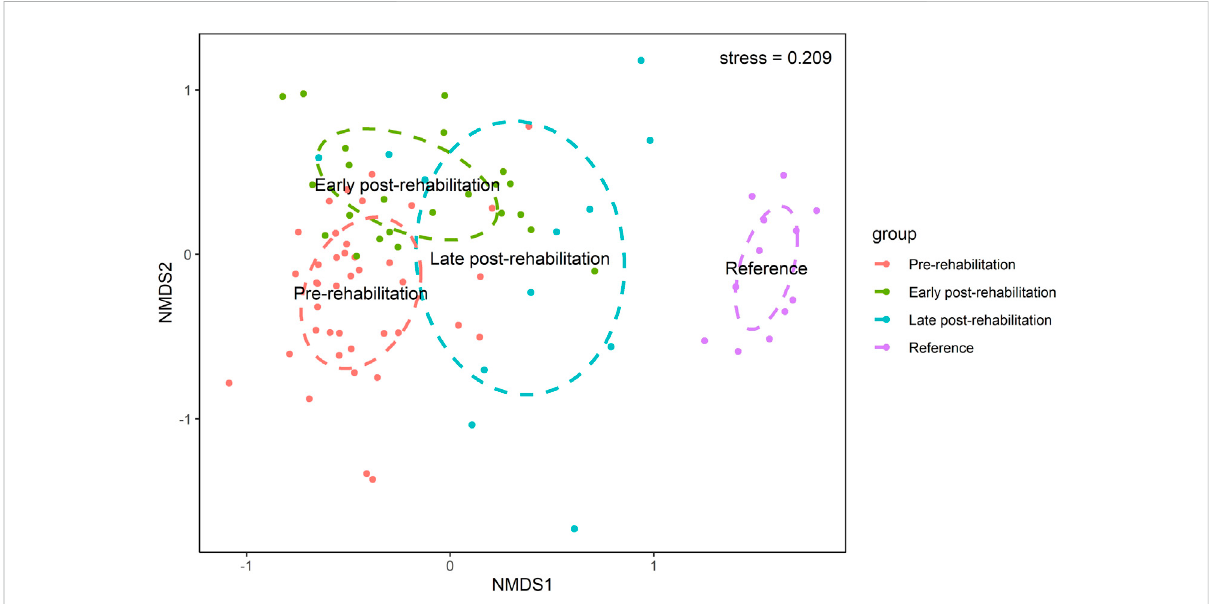
FIGURE 6 Non-metric Multi-dimensional Scaling comparing the taxonomic composition of benthic macroinvertebrate assemblages of rehabilitated and reference sites among the four time-groups.